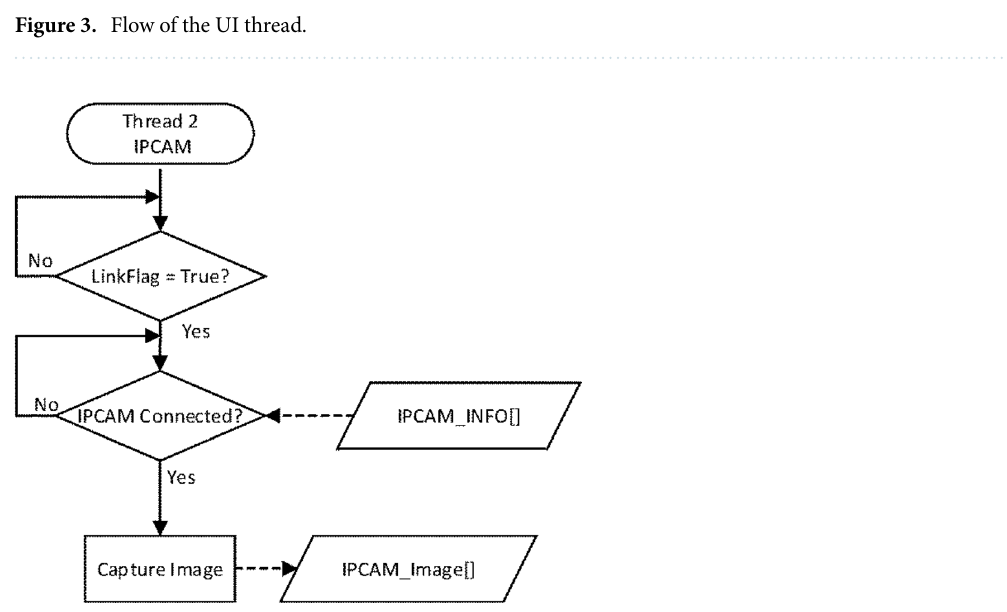
Figure 4. Flow of the IPCAM